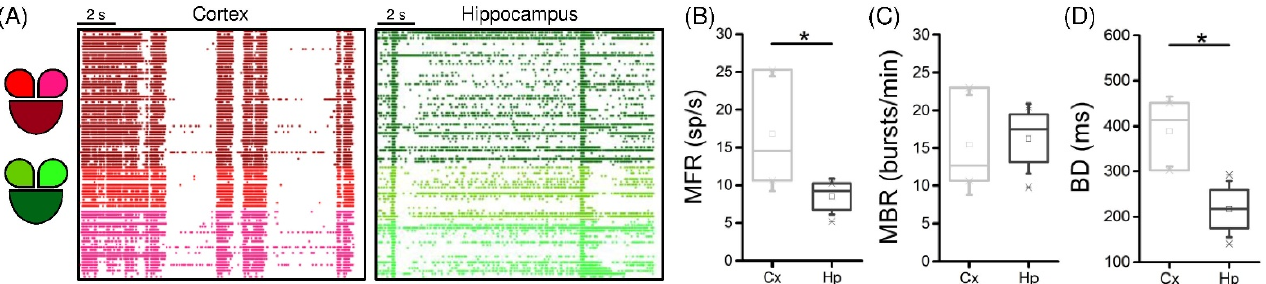
Figure 2. Spontaneous network activity of interconnected cortical (Cx) and hippocampal (Hp) as- semblies: ( A ) 16 s of spontaneous activity of cortical (shades of red ) and hippocampal (shades of green ) interconnected populations; ( B ) MFR; ( C ) MBR; ( D ) BD of the cortical ( light grey ) and the hippocampal ( dark grey ) populations (* refers to 0.01 < p < 0.05; Kruskal–Wallis nonparametric test).